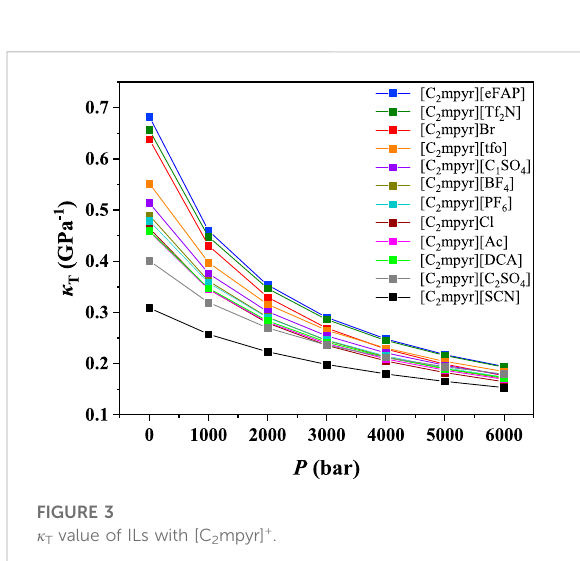
FIGURE 3 κ T value of ILs with [C 2 mpyr] + .